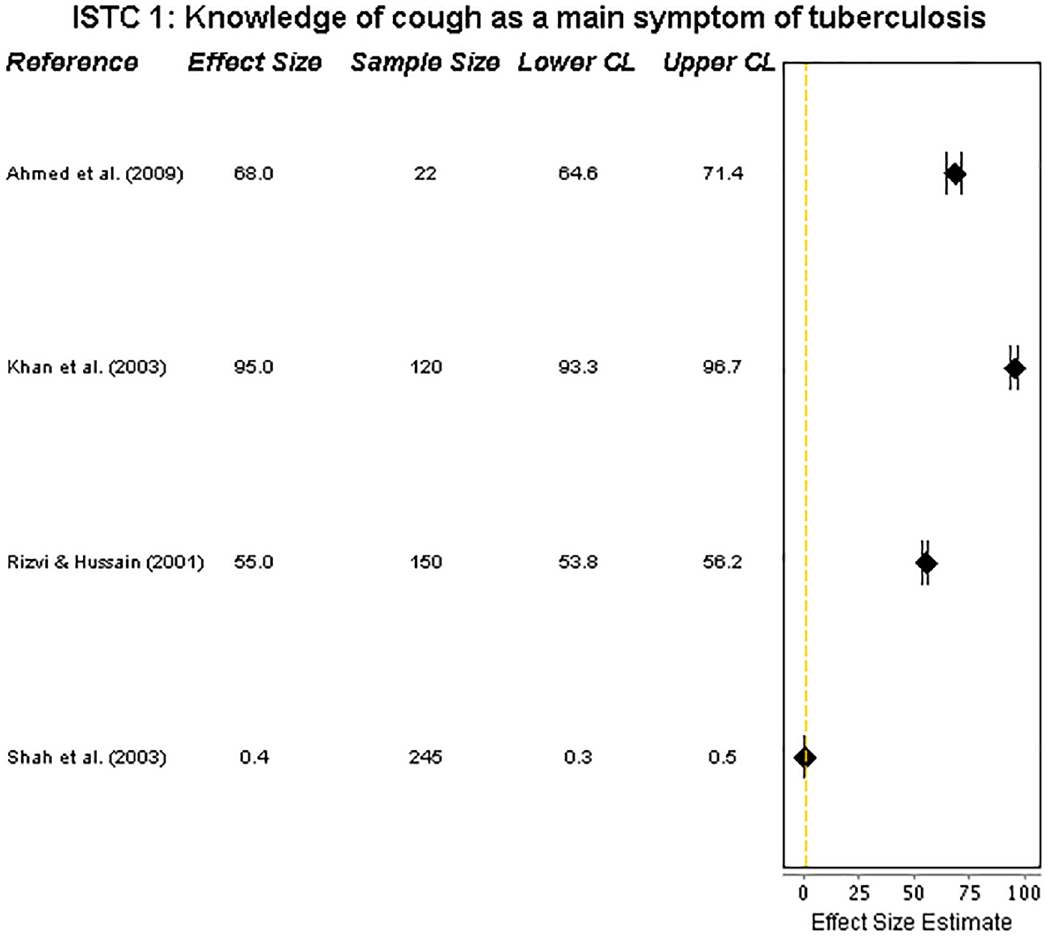
Fig 2. Forest plot on cough. Forest plot visualising data on practitioners’ knowledge of cough as a main symptom of tuberculosis (ISTC Standard 1). CL = 95% Confidence Level.